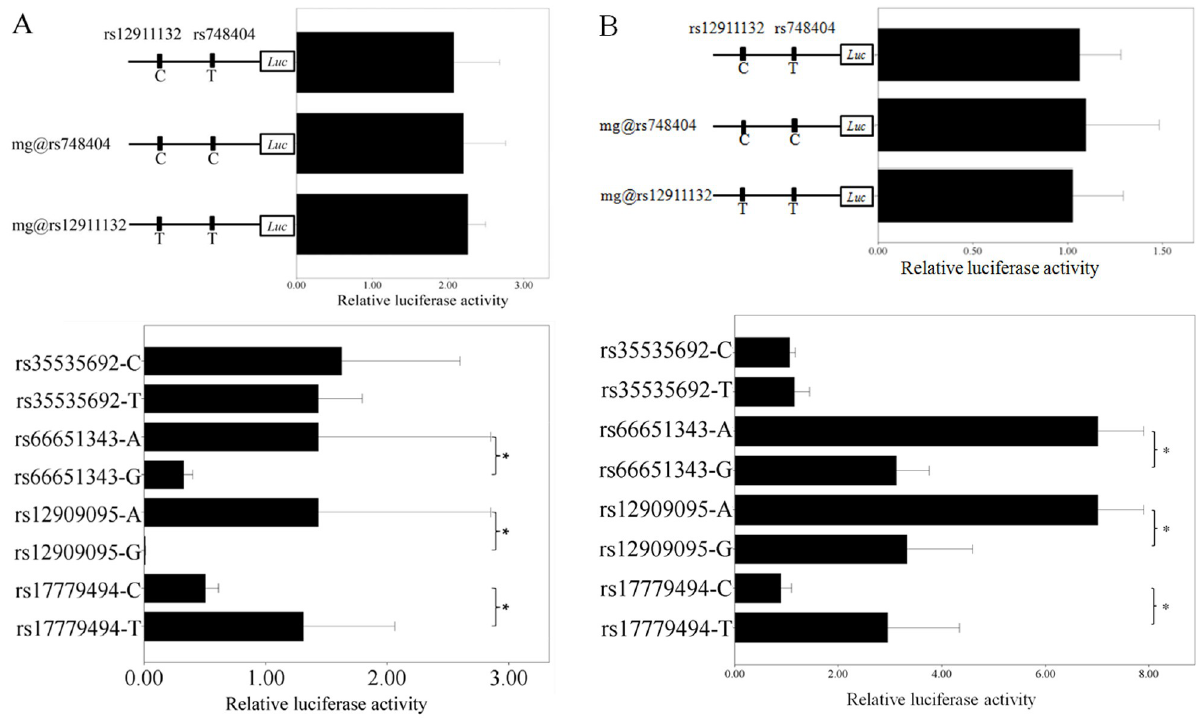
Fig 1. Relative luciferase activity for different alleles of the six SNPs in Beas-2B (A) or A549 (B) cell. For each part, the above chart is for promoter activity while the below one for enhancer. Each bar indicates one plasmid. For the two above charts, the above plasmid is the original construct, while the below two are from mutagenesis. Mg represents mutagenesis. For each SNP in below charts, the above allele is from haplotype 1 while the below one from haplotype 2. The x axis represents relative luciferase activity. All data is presented as mean ± standard deviation (SD) and normalized by the reading of empty vector. * represents P <